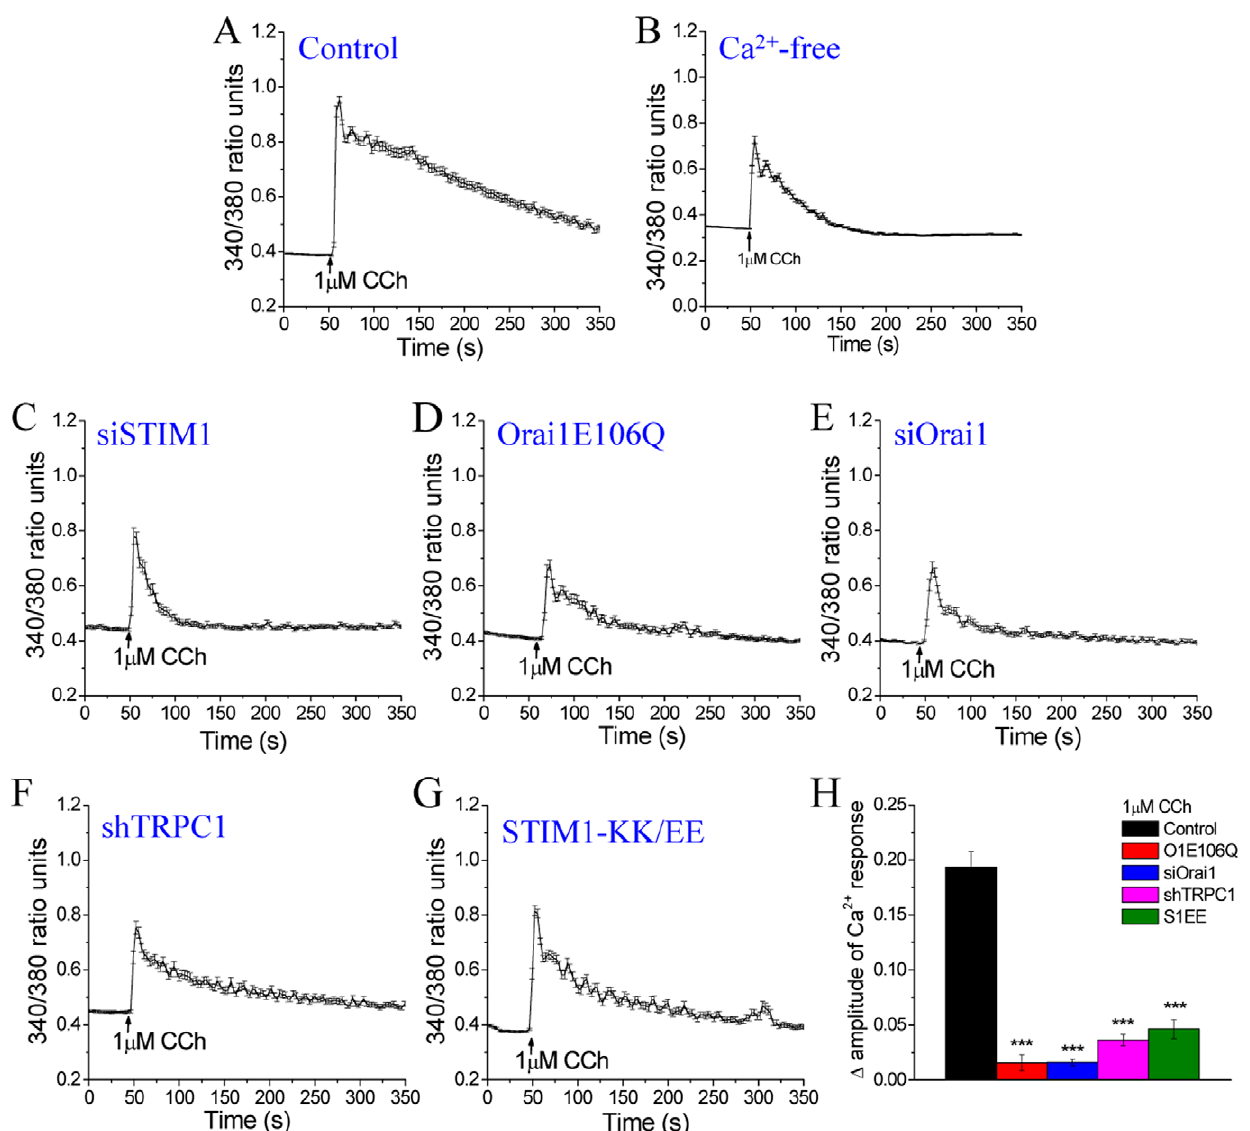
Figure 1. SOCE-driven [Ca 2 + ] i increases in HSG cells stimulated with relatively low [CCh]. Averaged [Ca 2 + ] i responses induced by relatively low [CCh] (1 m M) in control HSG cells, with and without extracellular Ca 2 + ( A, B ), and cells expressing siSTIM1 ( C ), Orai1E106Q ( D ), siOrai1 ( E ), shTRPC1 ( F ), or STIM1-KK/EE ( G ). Data for each trace were obtained from $ 50 cells in at least 3 separate experiments. ( H) Average data showing amplitude of [Ca 2 + ] i increase at t=250 s (F t 2 F 0 ). *** indicates a significant difference (P , 0.001, n $ 80 cells).